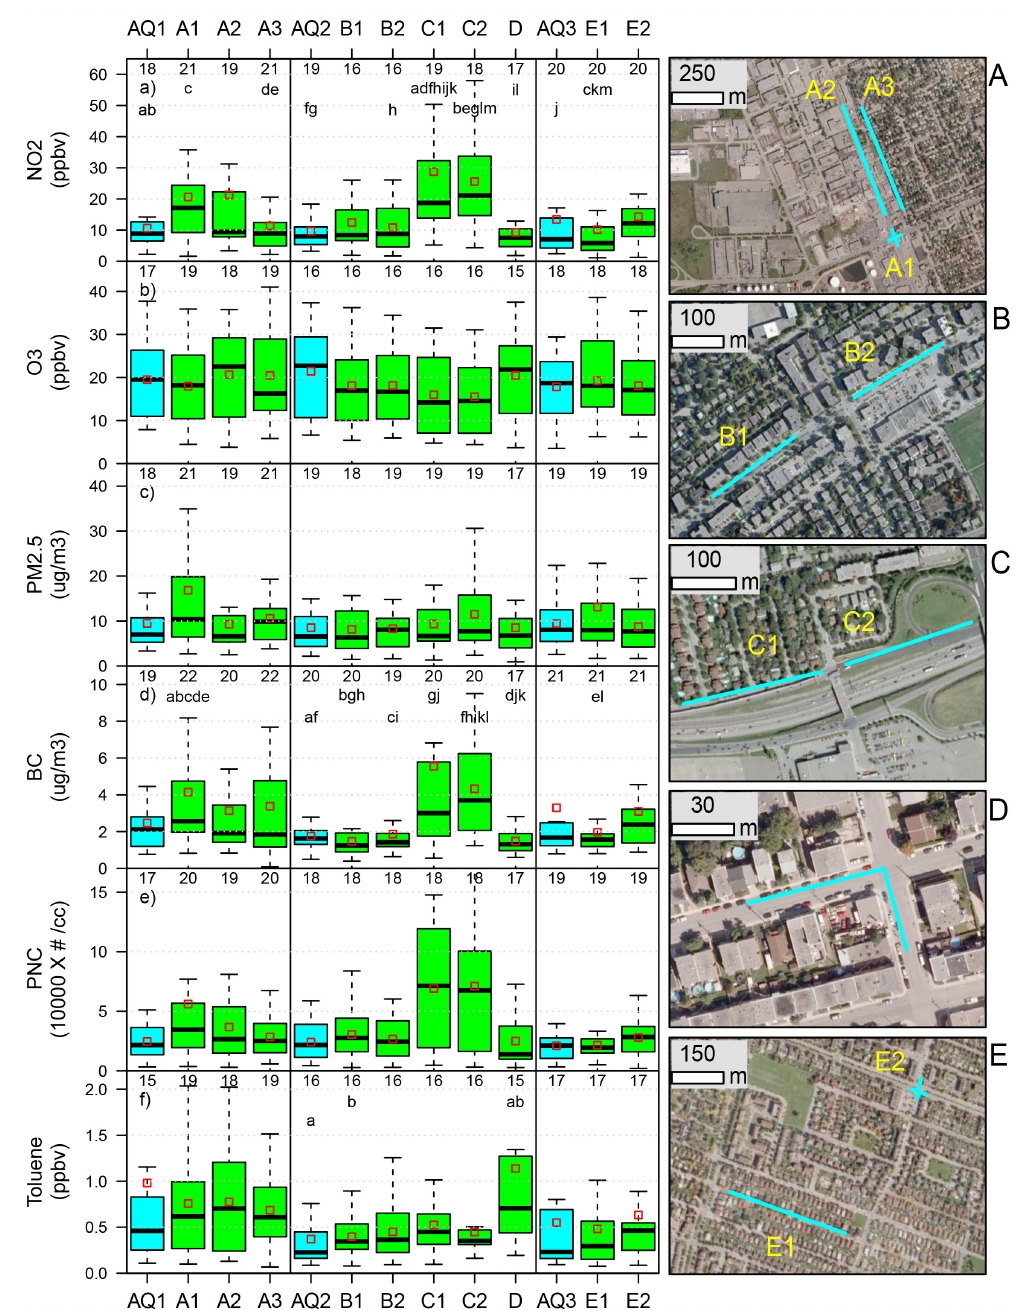
Figure 4. Box plots showing pollutant levels (NO 2 , O 3 , PM 2 . 5 , BC, PNC and toluene; (a–f) , respectively) at 10 different areas (green) compared to measurements taken next to three air quality monitoring sites (blue). Red squares are the mean and numbers above each box mark the number of days included in the statistics. The panels in the right-hand column show local settings of each area marked in blue (A–E) . See Fig. 1b for locations within the